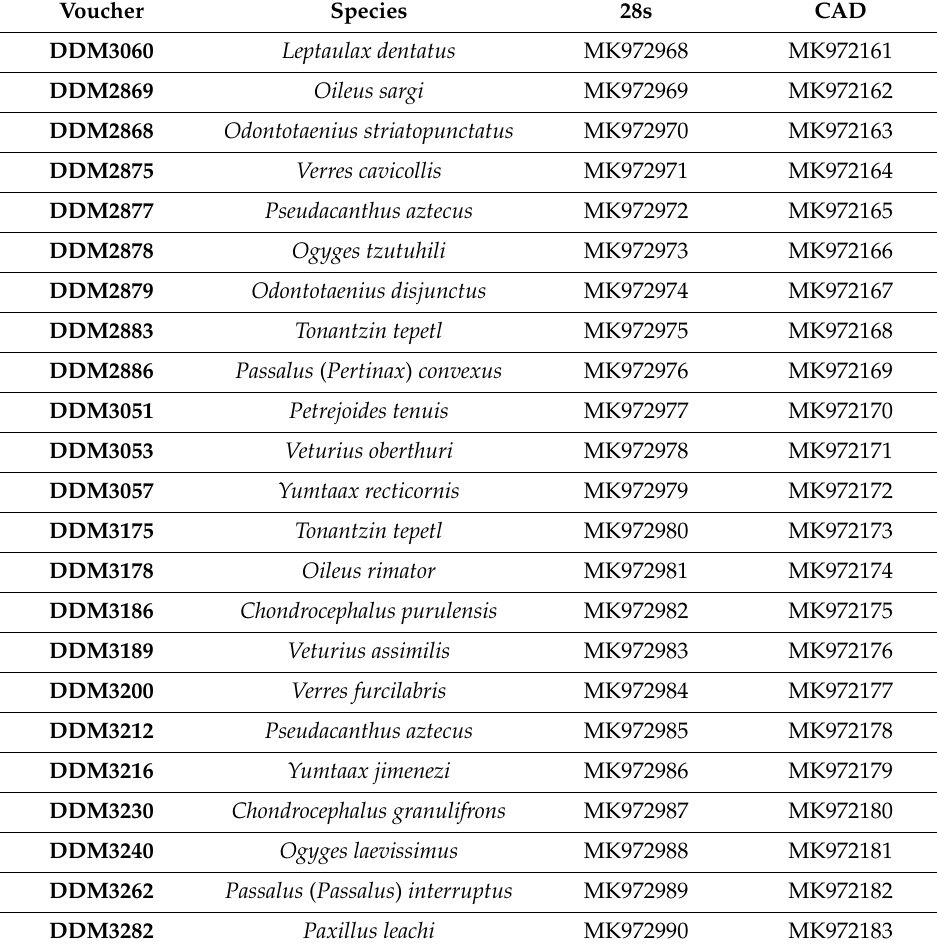
Table A1. Voucher information, species, and GenBank accession